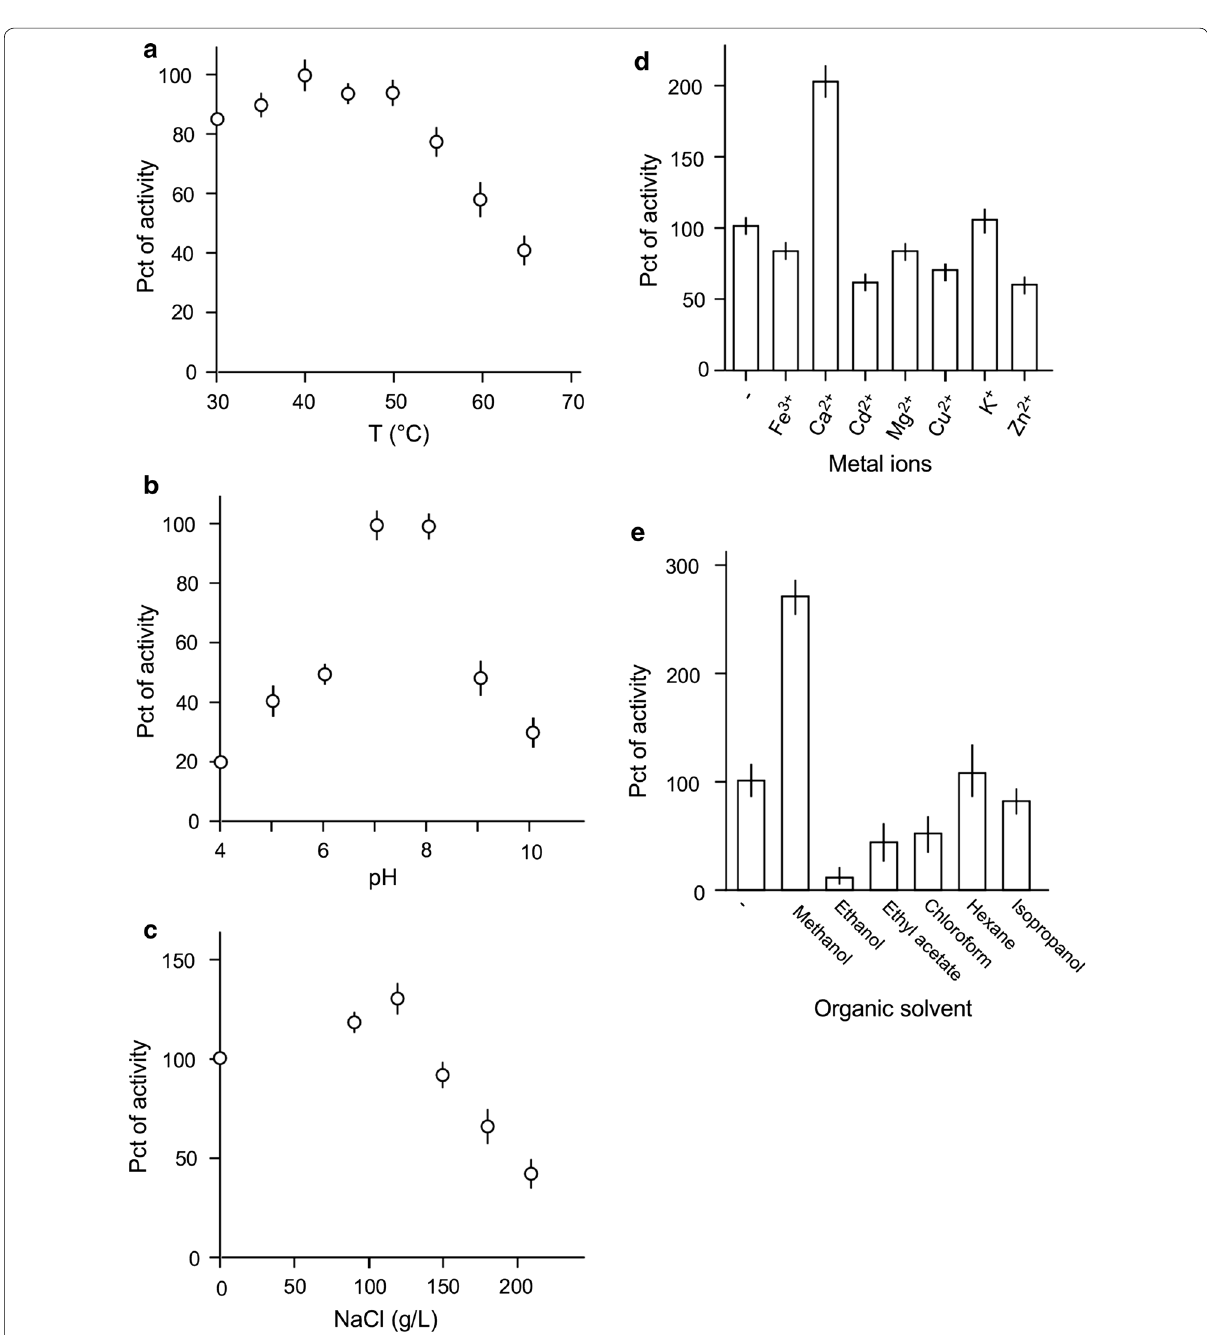
Fig. 5 ZS6 lipase activity at various conditions. Initial activity is based on the condition at 37 °C, pH 7, without salinity, and no additional metal ions or organic solvent. Lipase activity under conditions of various temperatures ( a ), acidities ( b ), salinities ( c ), metal ion additions ( d ), and